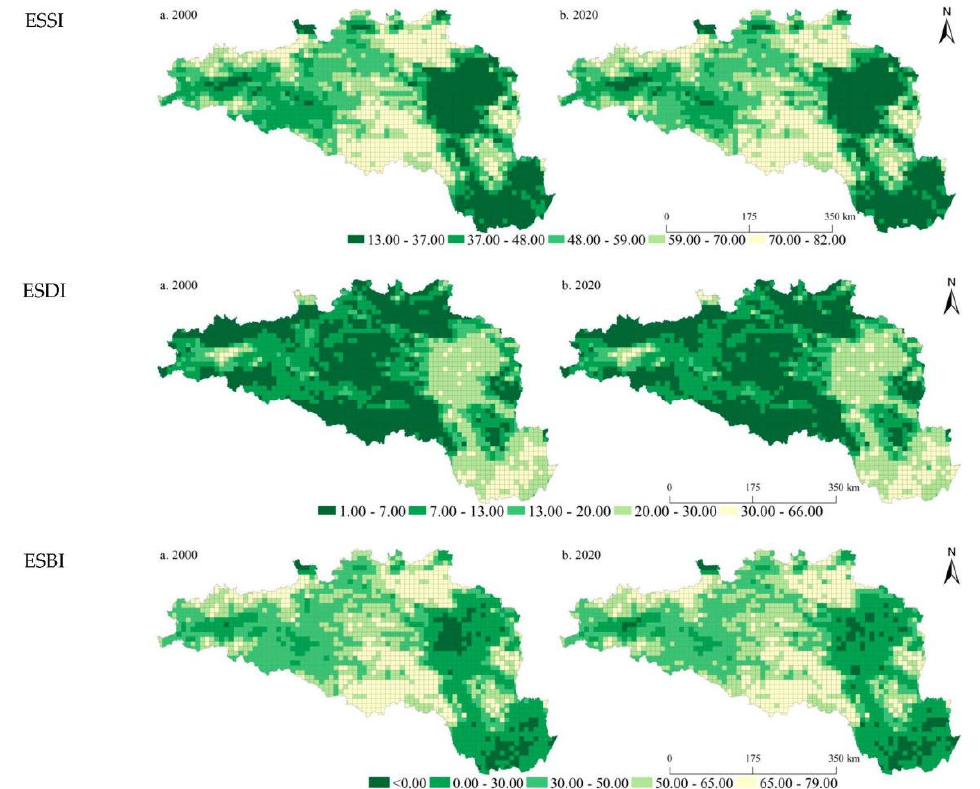
Figure 3. Spatial pattern of the ESSI, ESDI, and ESBI at the 10 km grid scale in the HREEB in